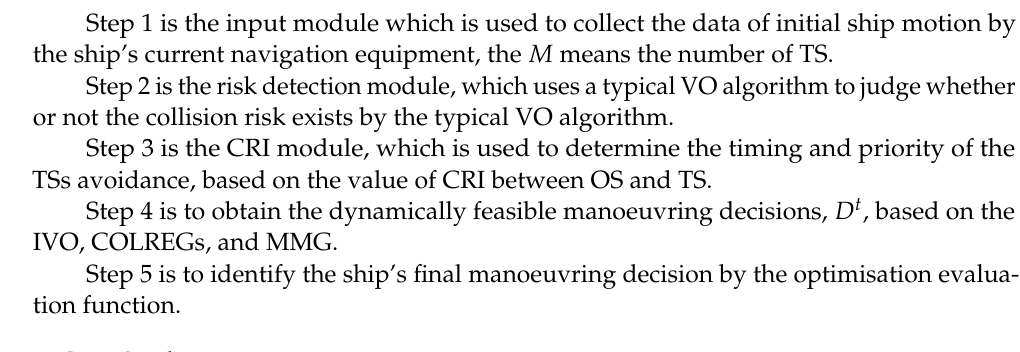
Table 2. Principal particulars and manoeuvrability characteristics of OS.